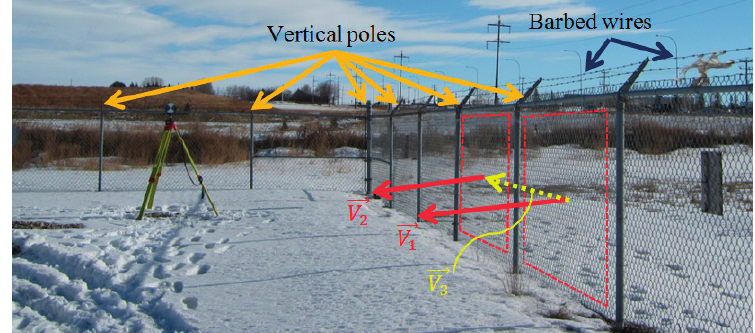
Figure 5. Fence recognition by detecting adjacent parallel planar segments, separated by vertical poles. The dashed polygons rectangles represent two planar segments.